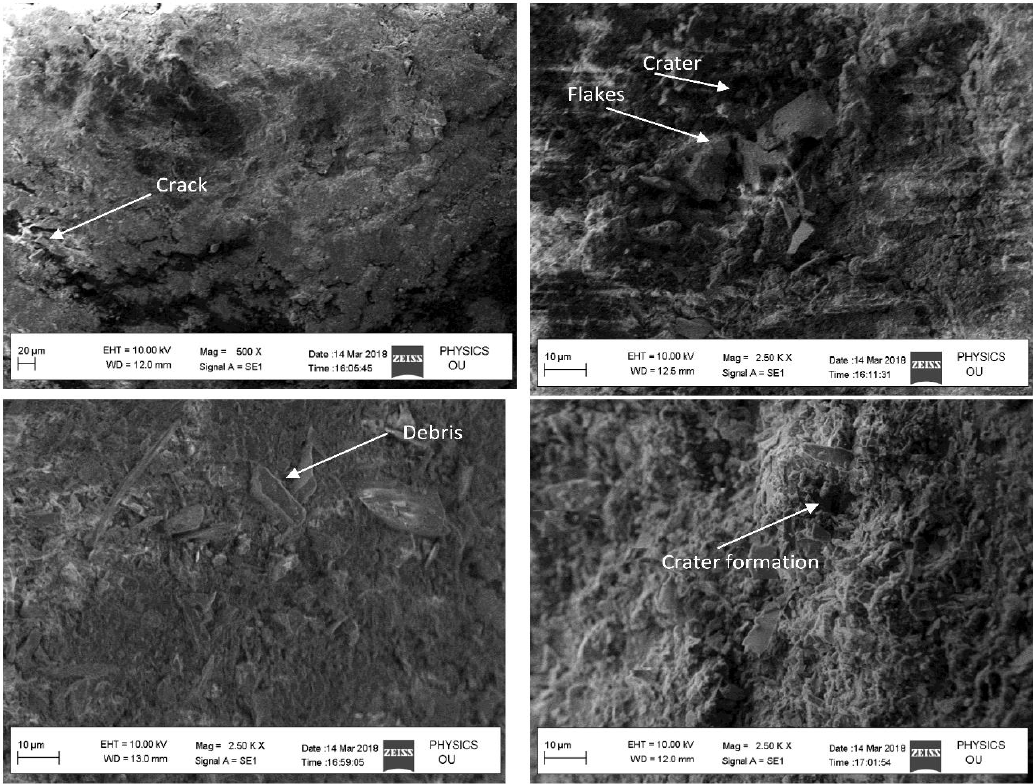
Figure 8. SEM images of worn surfaces at particle impact angle of 60 0 and at particle impact velocity of